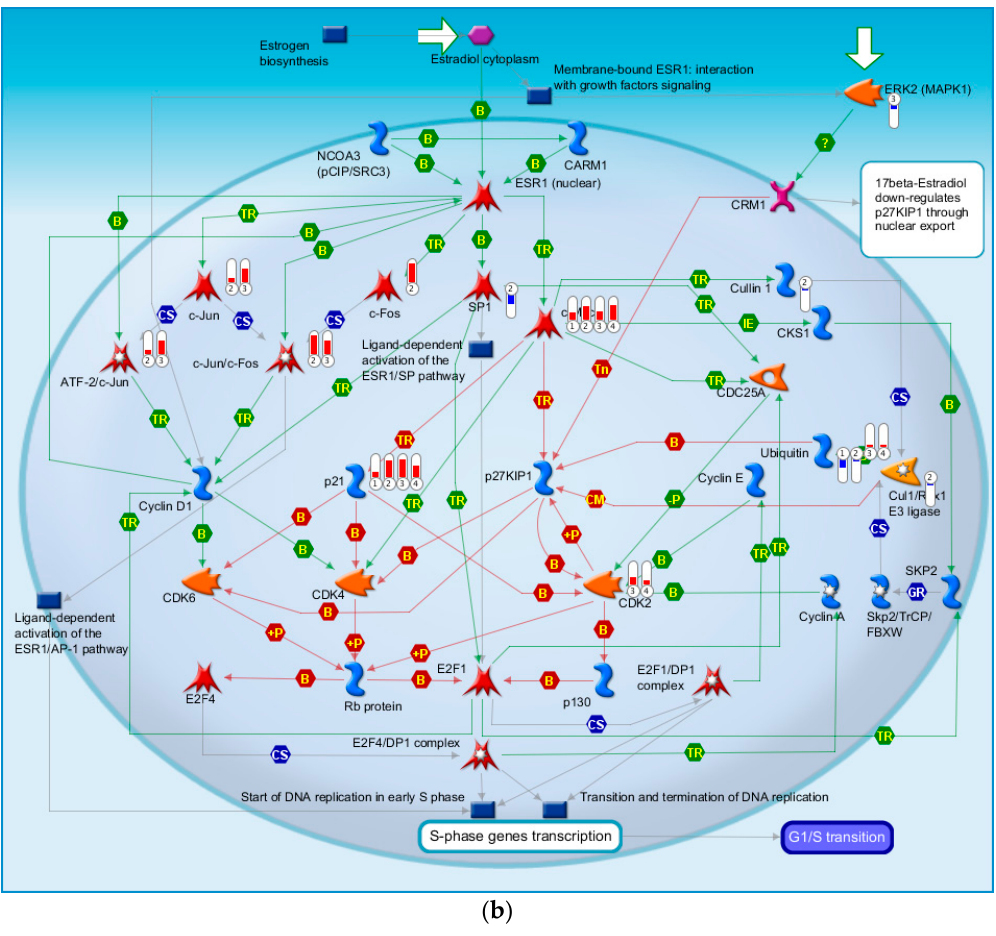
Figure 3. The two highest-scoring maps for all four time points post-TBI. ( a ) DNA damage ATM/ATR regulation of G1/S checkpoint; ( b ) Cell cycle ESR1 regulation of G1/S transition. These figures were generated by MetaCore™.